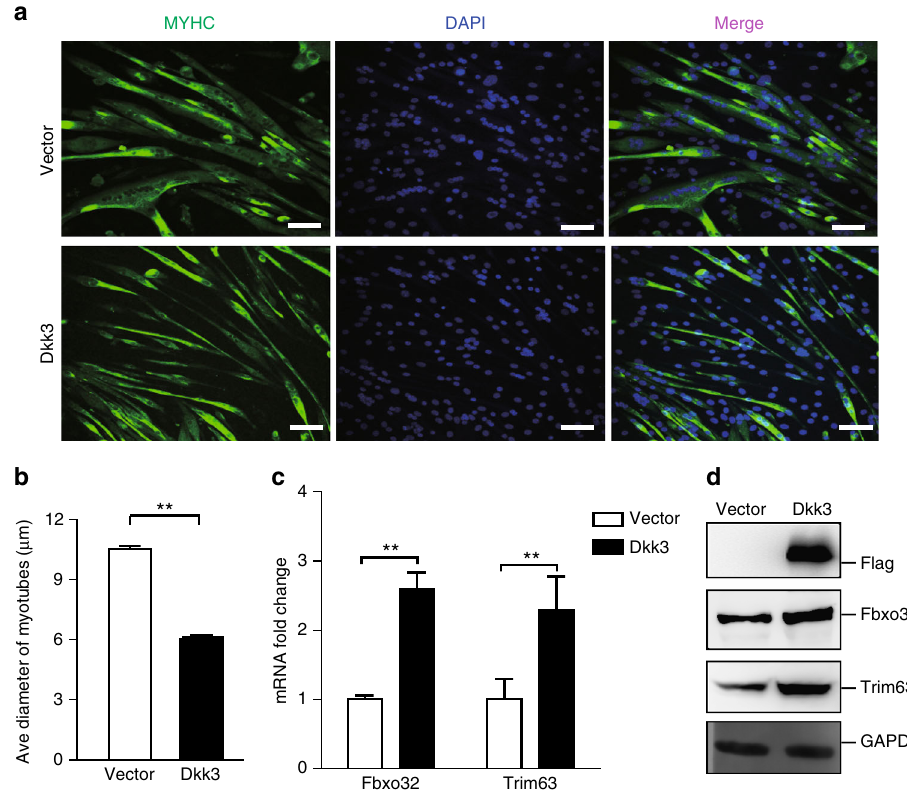
Fig. 2 Over-expression of Dkk3 -induced atrophy in cultured myotubes. a Representative images of myotubes over-expressing Dkk3 . Primary myotubes were infected by adenovirus-encoding Dkk3 or control vector. Seventy two hours after infection, the myotubes over-expressing Dkk3 were signi fi cantly thinner than those infected by control vector. Green indicated myosin heavy chain (MYHC) immuno fl uorescent staining. Blue indicated DAPI staining of nuclei; Merge indicated merged images of MYHC and DAPI. Scale bars, 50 μ m. b Quanti fi cation of the average diameters of the myotubes over-expressing Dkk3 or vector control. Error bars indicated s.d. and were based on three independent experiments. The diameters of 900 myotubes were measured in each experiment. ** indicated p < 0.01. c Fbxo32 and Trim63 expression levels increased after Dkk3 over-expression. Vector indicated myotubes infected with adenovirus-encoding vector control. Dkk3 indicated myotubes infected with adenovirus-encoding Dkk3. Error bars indicated s.d. and were based on three independent experiments. ** indicated p < 0.01. d Over-expression of Dkk3 increased the protein levels of Fbxo32 and Trim63. Immunoblotting assays were performed with whole-cell extracts from myotubes over-expressing Dkk3 or vector control. Dkk3 was tagged with Flag tag. GAPDH served as internal control. All p -values were based on two-tailed t-